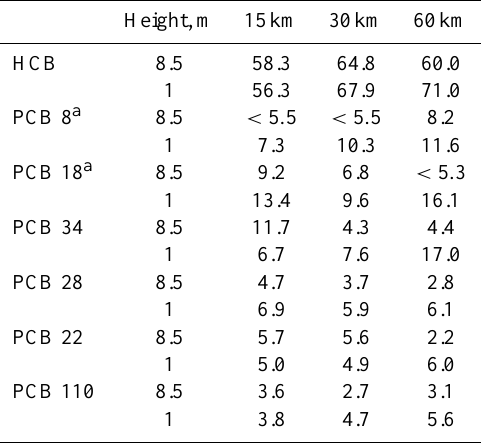
Table 4. Atmospheric PBT concentration measured at the upper (8.5-m) and lower (1-m) platforms at 15-, 30-, and 60-km stations in Lake Superior, 14 July 2006 (pgm − 3 at 25 ◦ C, 1atm).